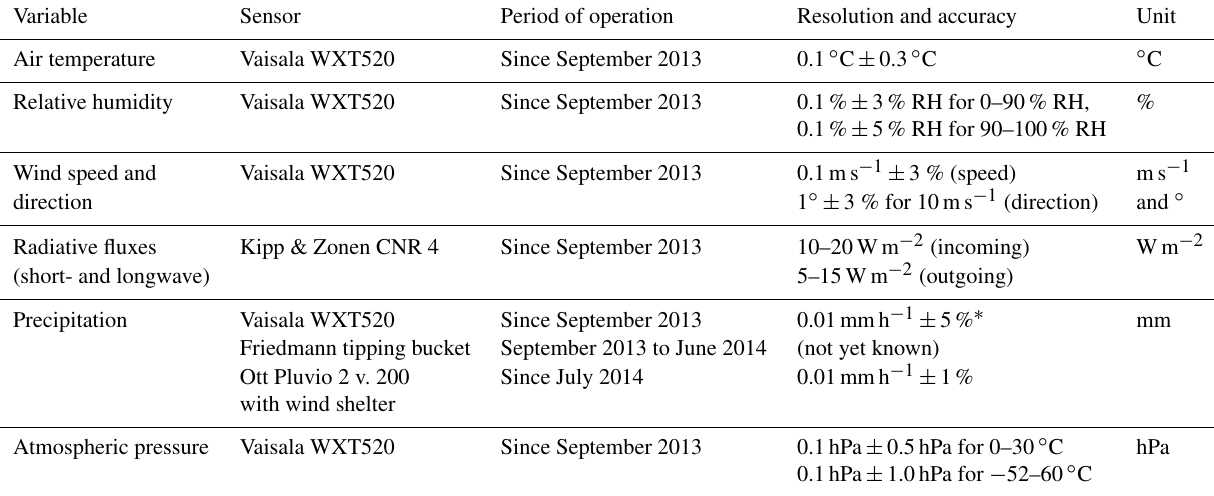
Table 5. Climate and snow variables recorded by the sensors installed at the station Latschbloder (2919ma.s.l., 46.80106 ◦ N, 10.80659 ◦ E). Accuracy according to technical data sheets of the manufacturers. Original temporal resolution of the data records is 10min.